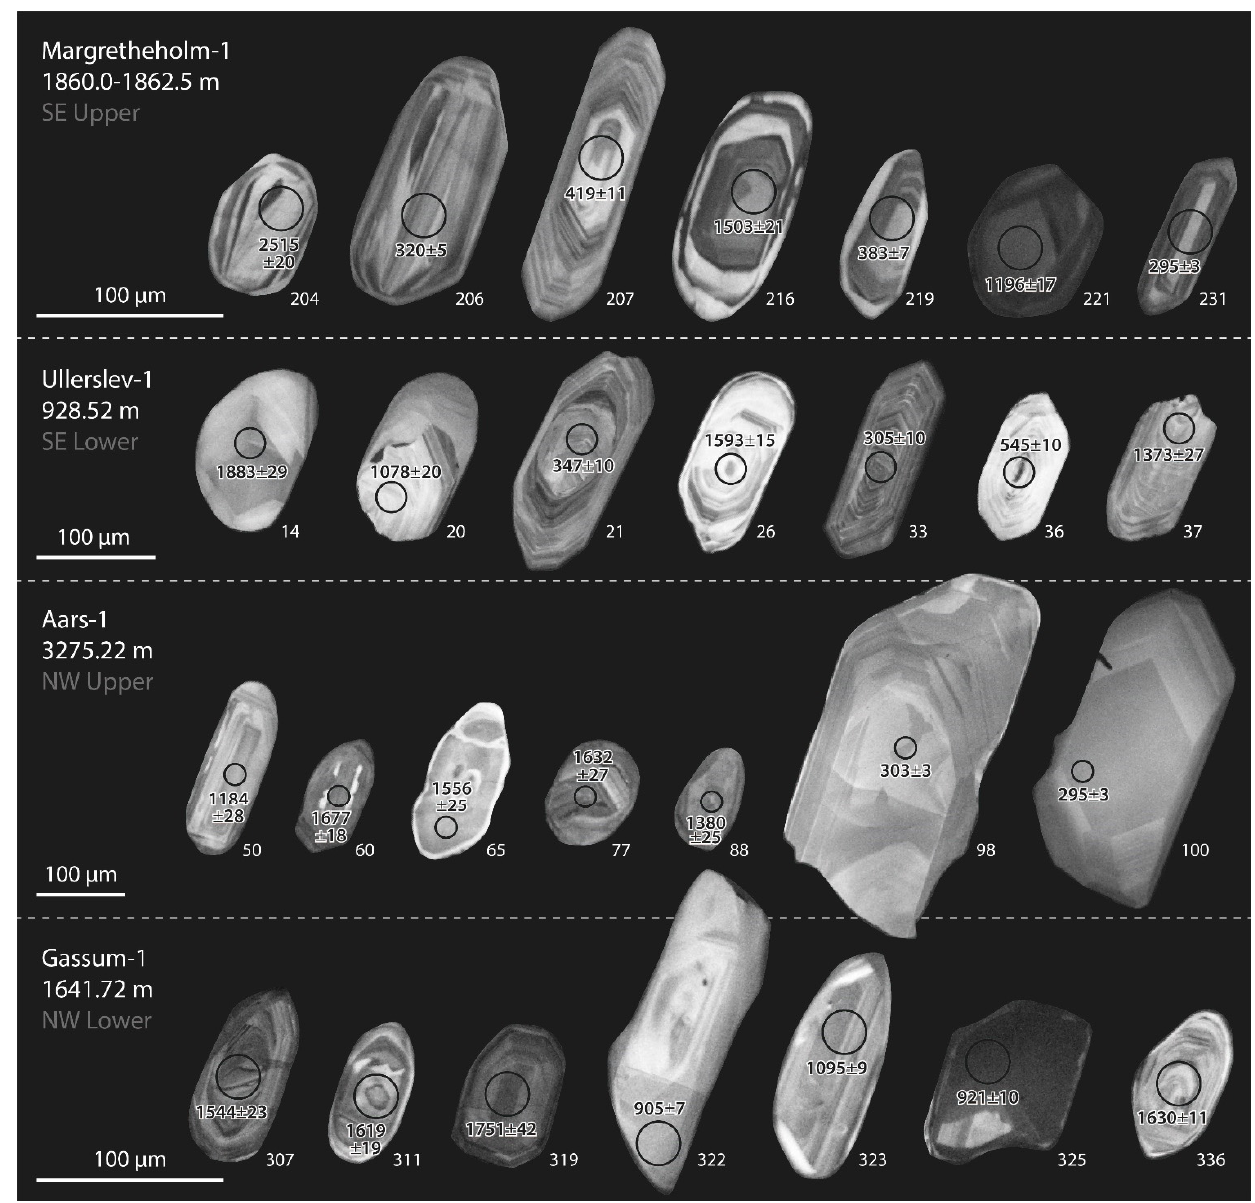
Figure 4. Cathodoluminescence images showing typologies and internal texture of representative zircon grains from selected samples including one from each of the NW Lower, NW Upper, SE Lower, and SE Upper regions. The analysis spots and U-Pb dates (Ma) are indicated, along with the spot numbers.